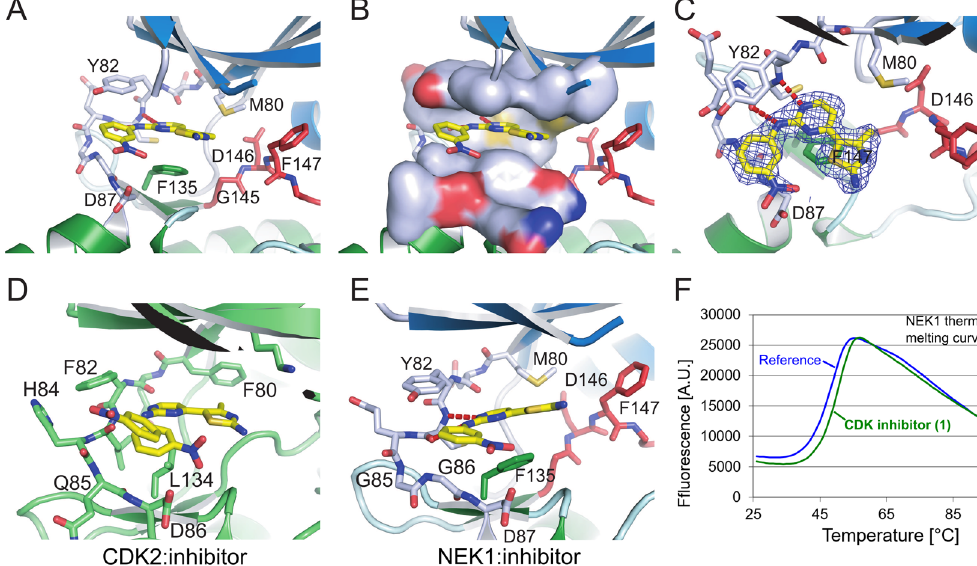
Figure 2. Inhibitor Binding to NEK1 kinase domain ( A ) Binding of CDK2/CDK9 inhibitor 1 to NEK1. The inhibitor is shown in yellow, and the DFG motif of NEK1 is shown in red. ( B ) As A, with a molecular surface shown around the NEK1 ATP binding site residues above and below the bound inhibitor, illustrating the tight fit of the inhibitor between Phe135, Met80 and Tyr82. ( C ) As A, viewed from above the inhibitor with an experimental 2F o -F c electron density shown contoured around the inhibitor at σ = 1.0. ( D , E ) CDK2 (PDB ID 1PXO) and NEK1 structures bound to inhibitor 1 and viewed from the same angle, showing the difference in binding angle of 1 . ( F ) The inhibitor 1 was identified by its thermal stabilisation ( Δ Tm) of NEK1 kinase